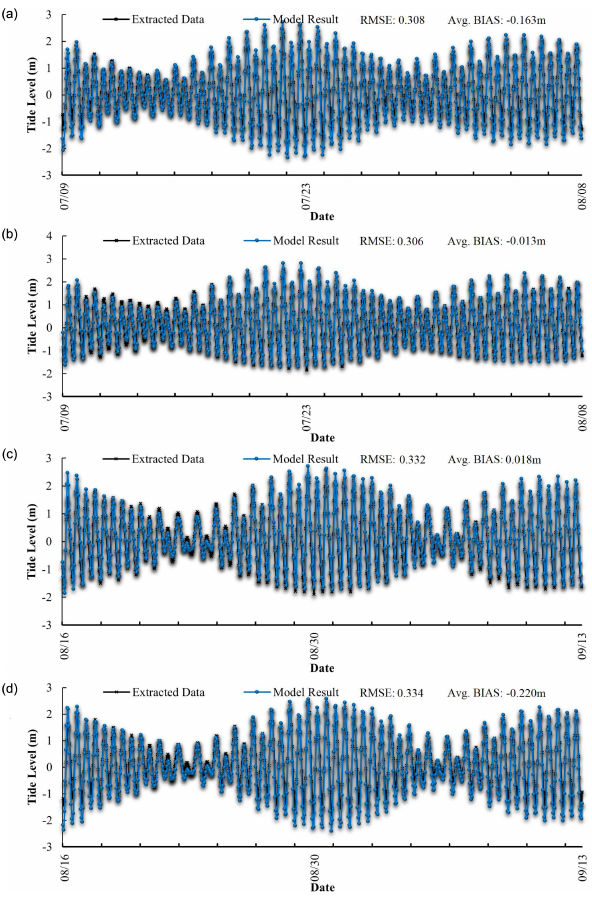
Figure 4. Time series of tide level (unit: m) at the tide gauge stations (Sheshandao and Zhongjun stations) presented in Fig. 2. Panels (a) and (b) present tide level at Sheshandao and Zhongjun stations from 8 July to 8 August 1997 before Typhoon Winnie, while (c) and (d) present tide level at Sheshandao and Zhongjun stations from 15 Au- gust to 15 September 2007 before Typhoon Wipha. The black line indicates the extracted data, while the computed results from the SC-TSSM are shown with the blue line.